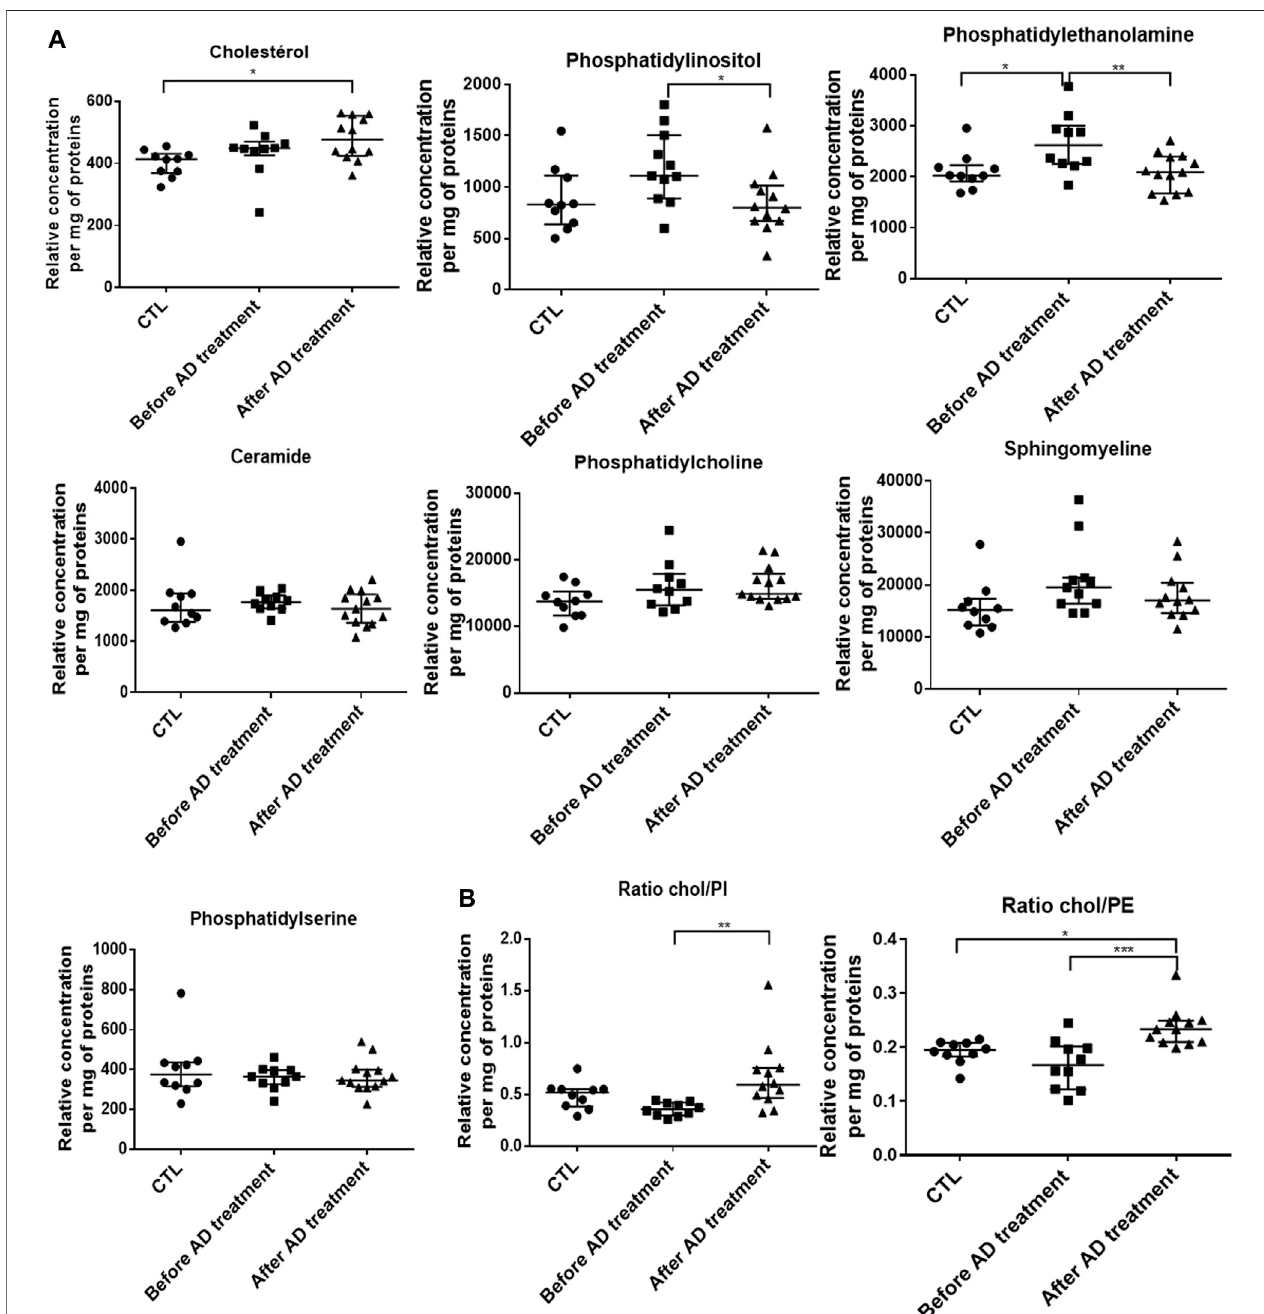
FIGURE 2 | Alterations of cholesterol and phospholipid RBC membrane composition before and after antimalarial therapy in severe malaria. (A) . Lipid content of RBC membranes using HPLC and MS/MS on samples from 10 healthy donors (CTL), patients sampled before (N = 10) and after (N = 12) antimalarial therapy. (B) . Cholesterol/Phosphatidylethanolamine (ratio Chol/PE) and Cholesterol/Phosphatidylinositol (ratio Chol/PI). Stars indicate signi fi cant differences.